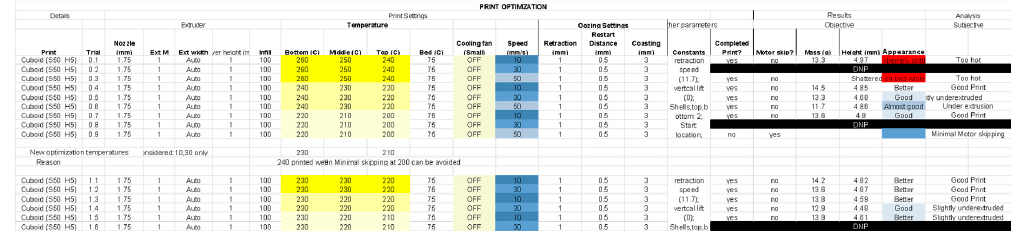
Figure A4. Print optimization with no-fan, large short cuboid.